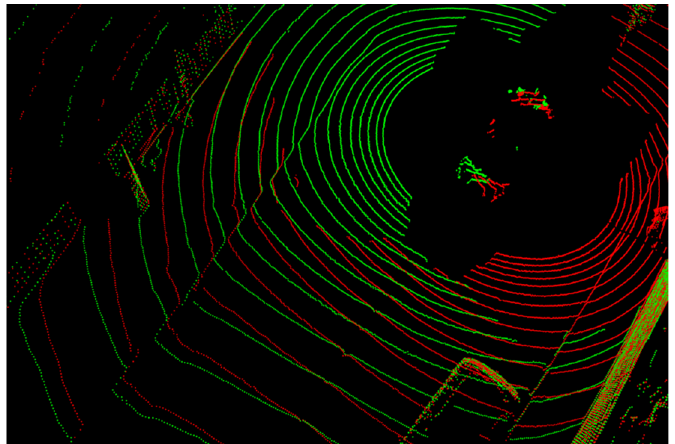
Figure 2. Point cloud constituting one frame in the Oxford dataset. The green dots represent points obtained by the right LiDAR, and the red dots represent the points obtained by the left LiDAR.